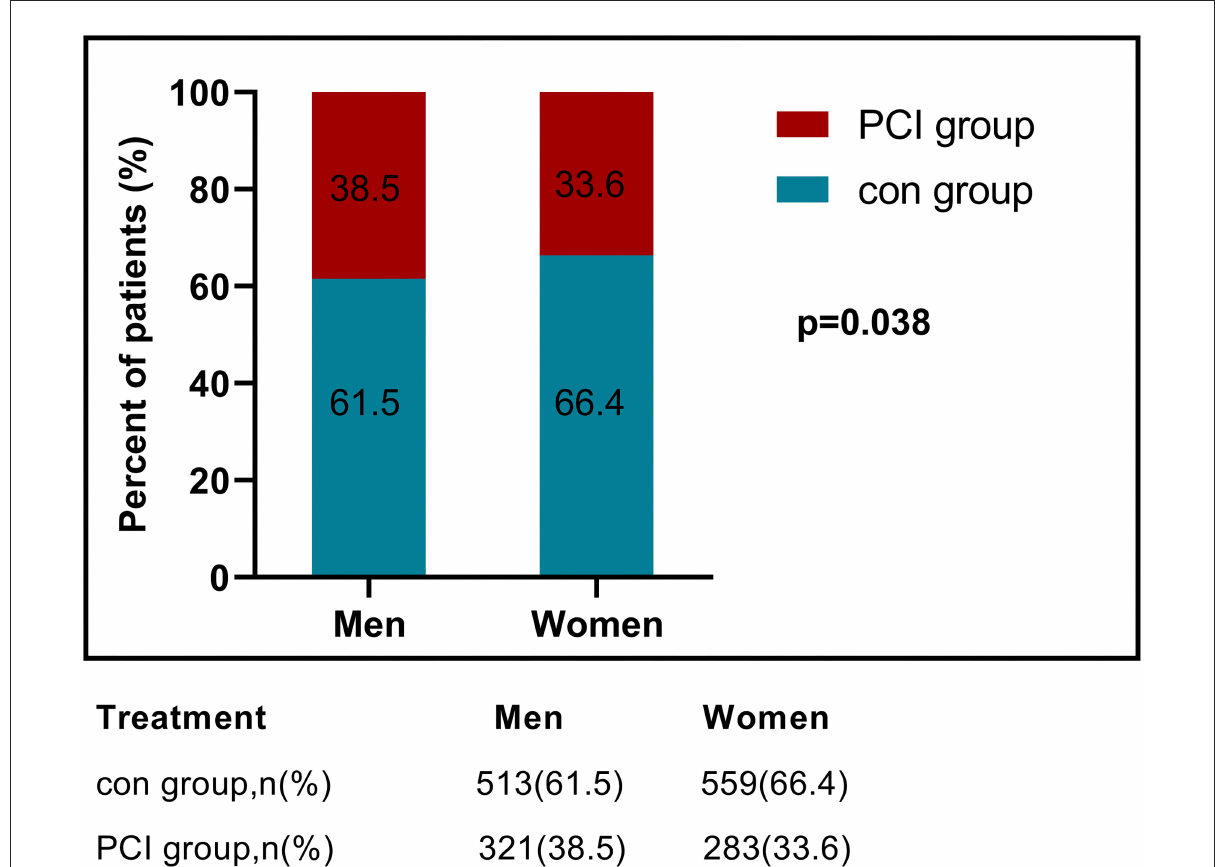
FIGURE2 Treatment decisions according to gender. PCI, percutaneous coronary intervention; con, conservative